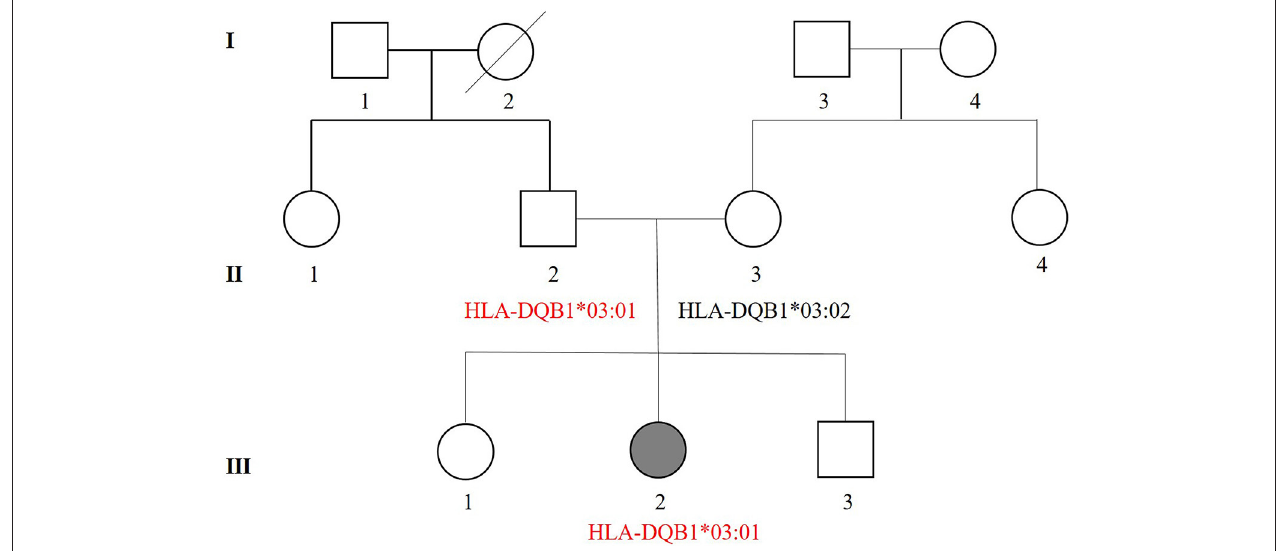
FIGURE 2 | Pedigree of the three-generation (I–III) patient’s family. Squares denote males while circles denotes females. Shadow symbols indicate affected individuals, while open symbols represent unaffected individuals. Diagonal lines are used to show that a person is died. Information regarding HLA genotypes associated with EM is also included in the pedigree. II-2 without a history of EM shows the same haplotypes ( HLA-DQB1 * 03:01 ) as the patient with EMM (III-2).